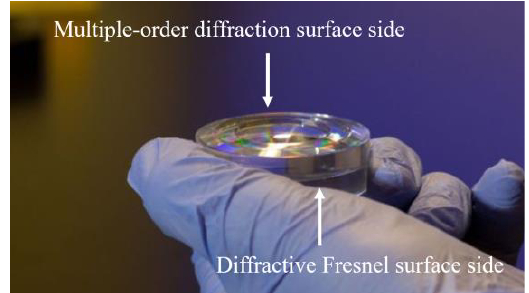
Fig. 1. Rendering of Nautilus fleet consisting of multiple unit telescope array during the space deployment phase .